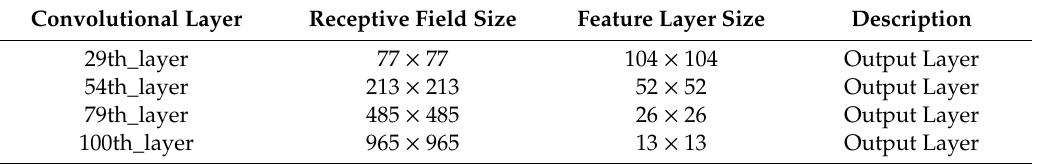
Table 4. The receptive field size of the last feature layer of relevant size in the improved